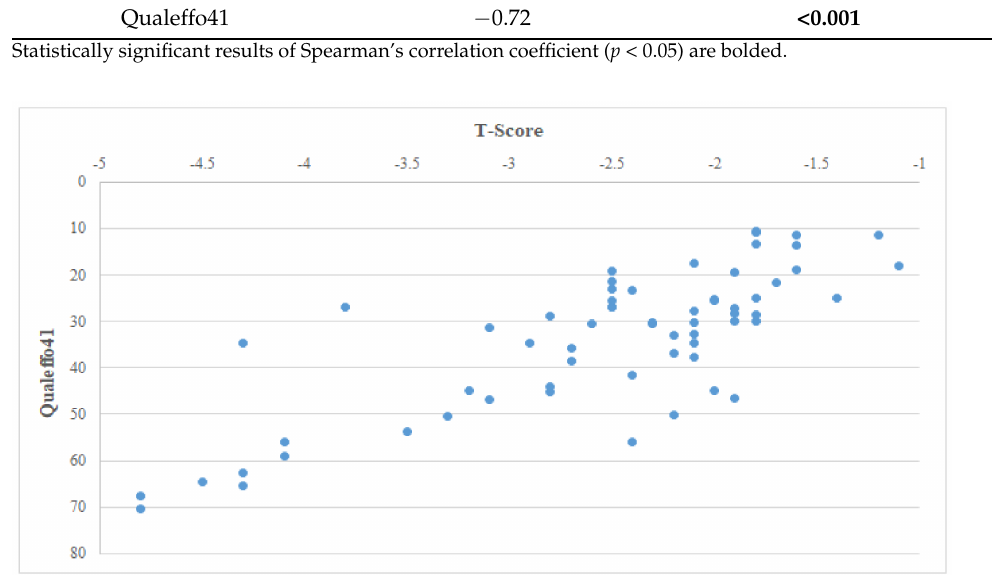
Figure 1. Scatter plot of participants’ bone density (T-score) and quality of life (Qualeffo41). The distribution of data points corresponds to a strong correlation between these